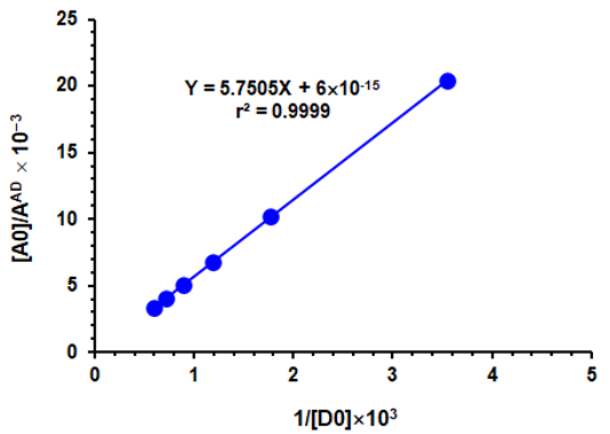
Figure 4. Benesi–Hildebrand plot of the CT complex of CLA with SEL, and the linear fitting equation with correlation coefficient (r). [A 0 ], A AD and [D 0 ] are the molar concentration of CLA, absorbance of the complex reaction mixture and molar concentration of SEL,